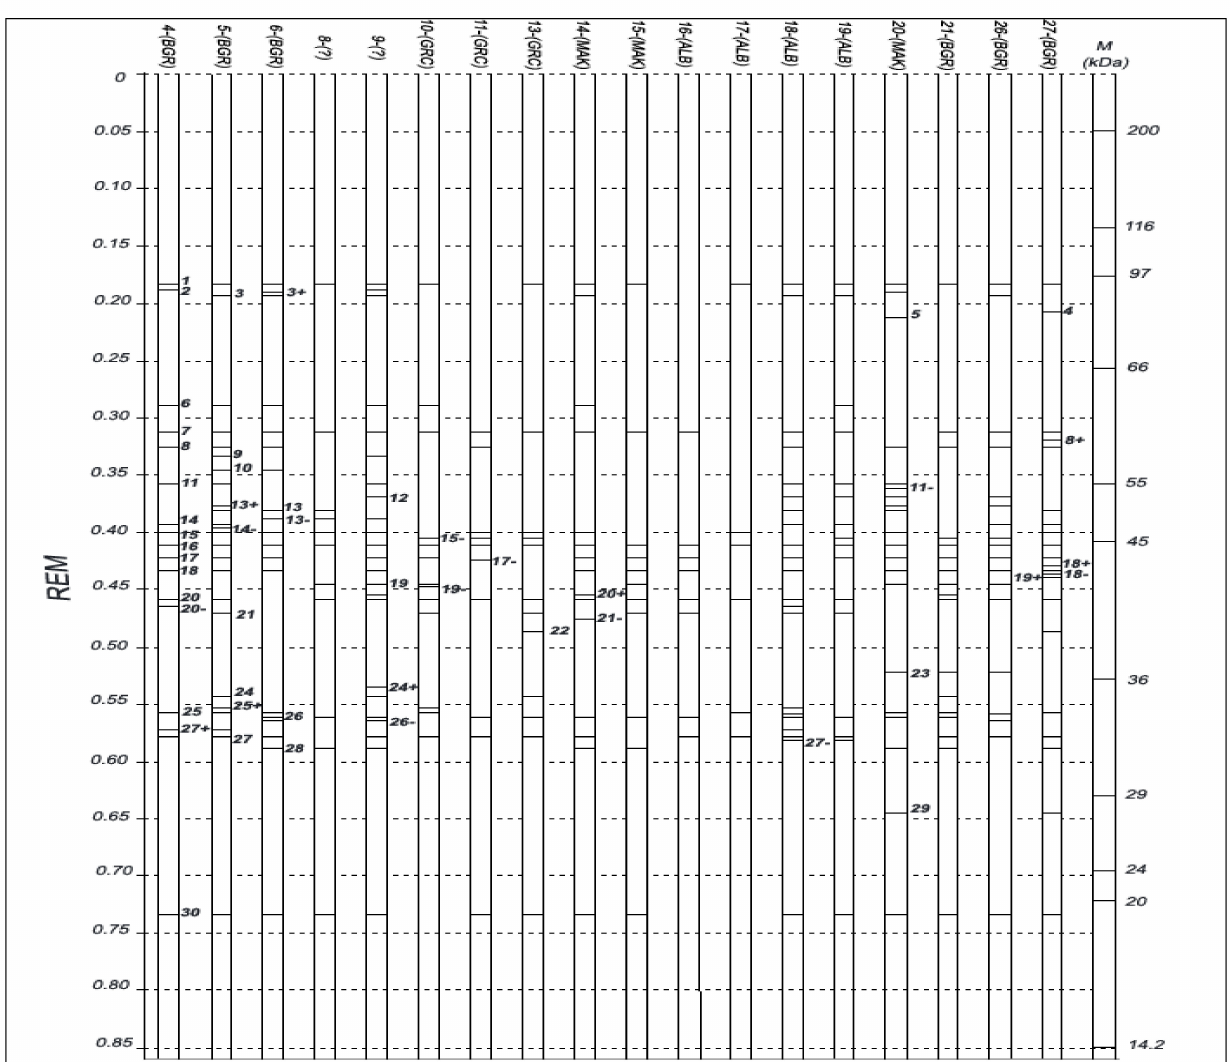
Figure 4. Schematic electrophoreogram (SDS-PAGE) of all detected HMW- and LMW-Glu combinations in individual populations of Dasypyrum villosum